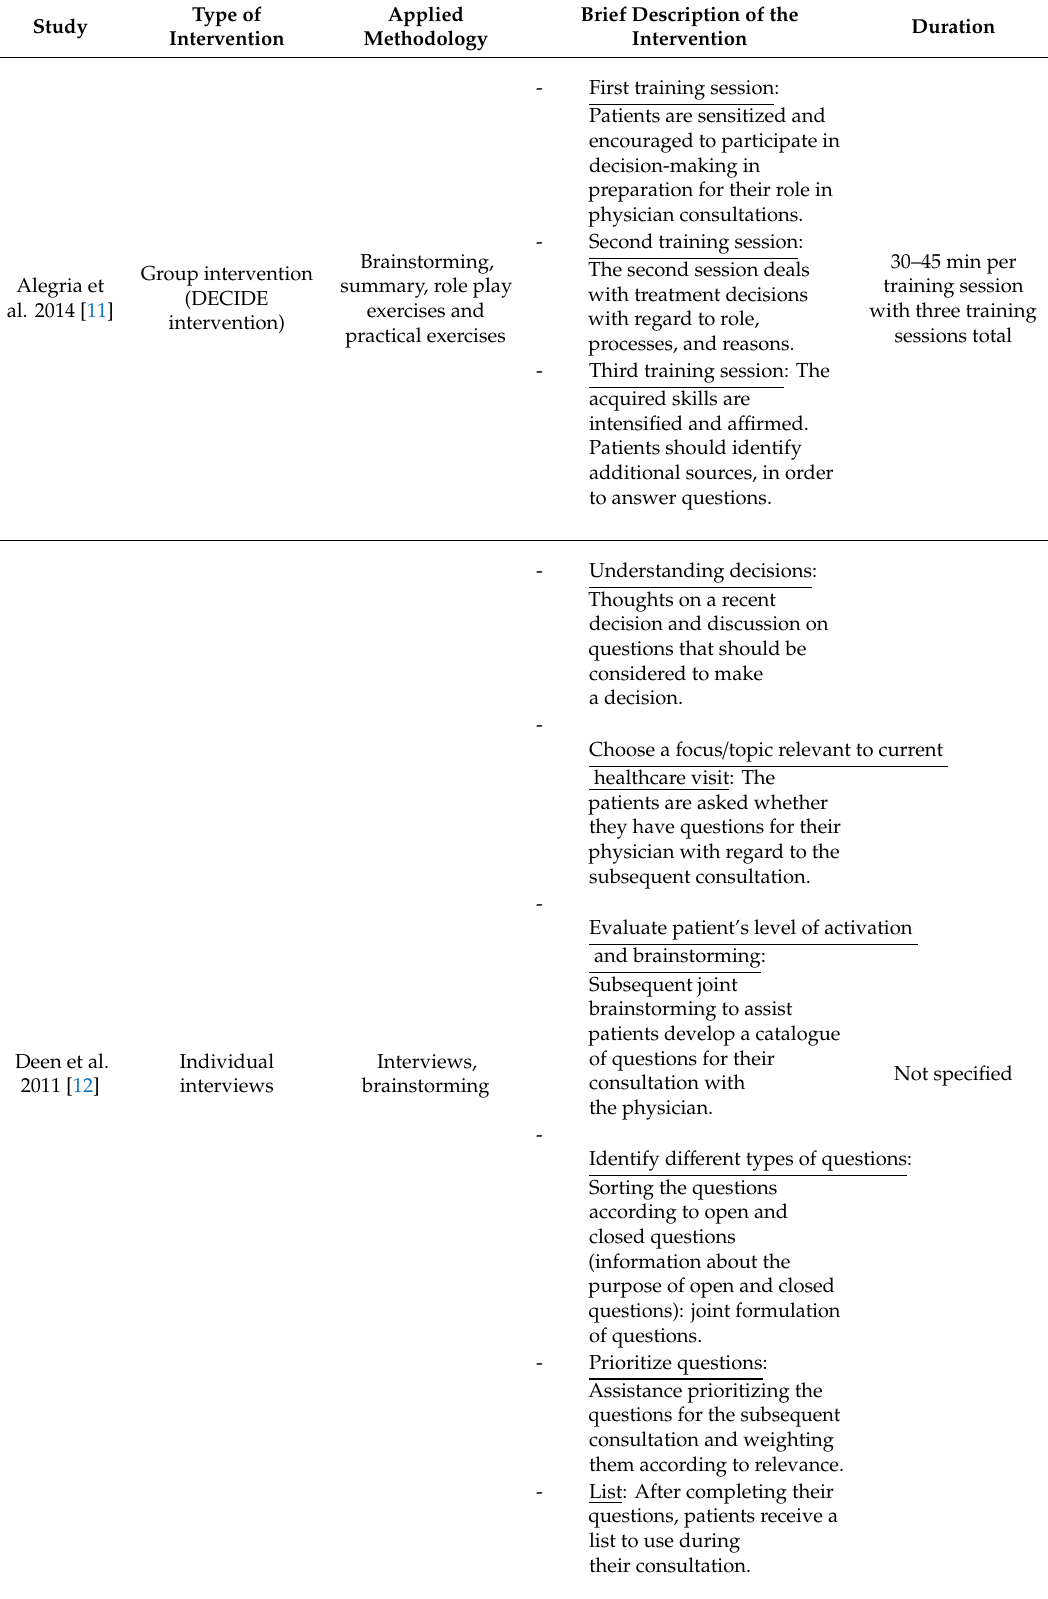
Table 2. Interventions—Studies on patient